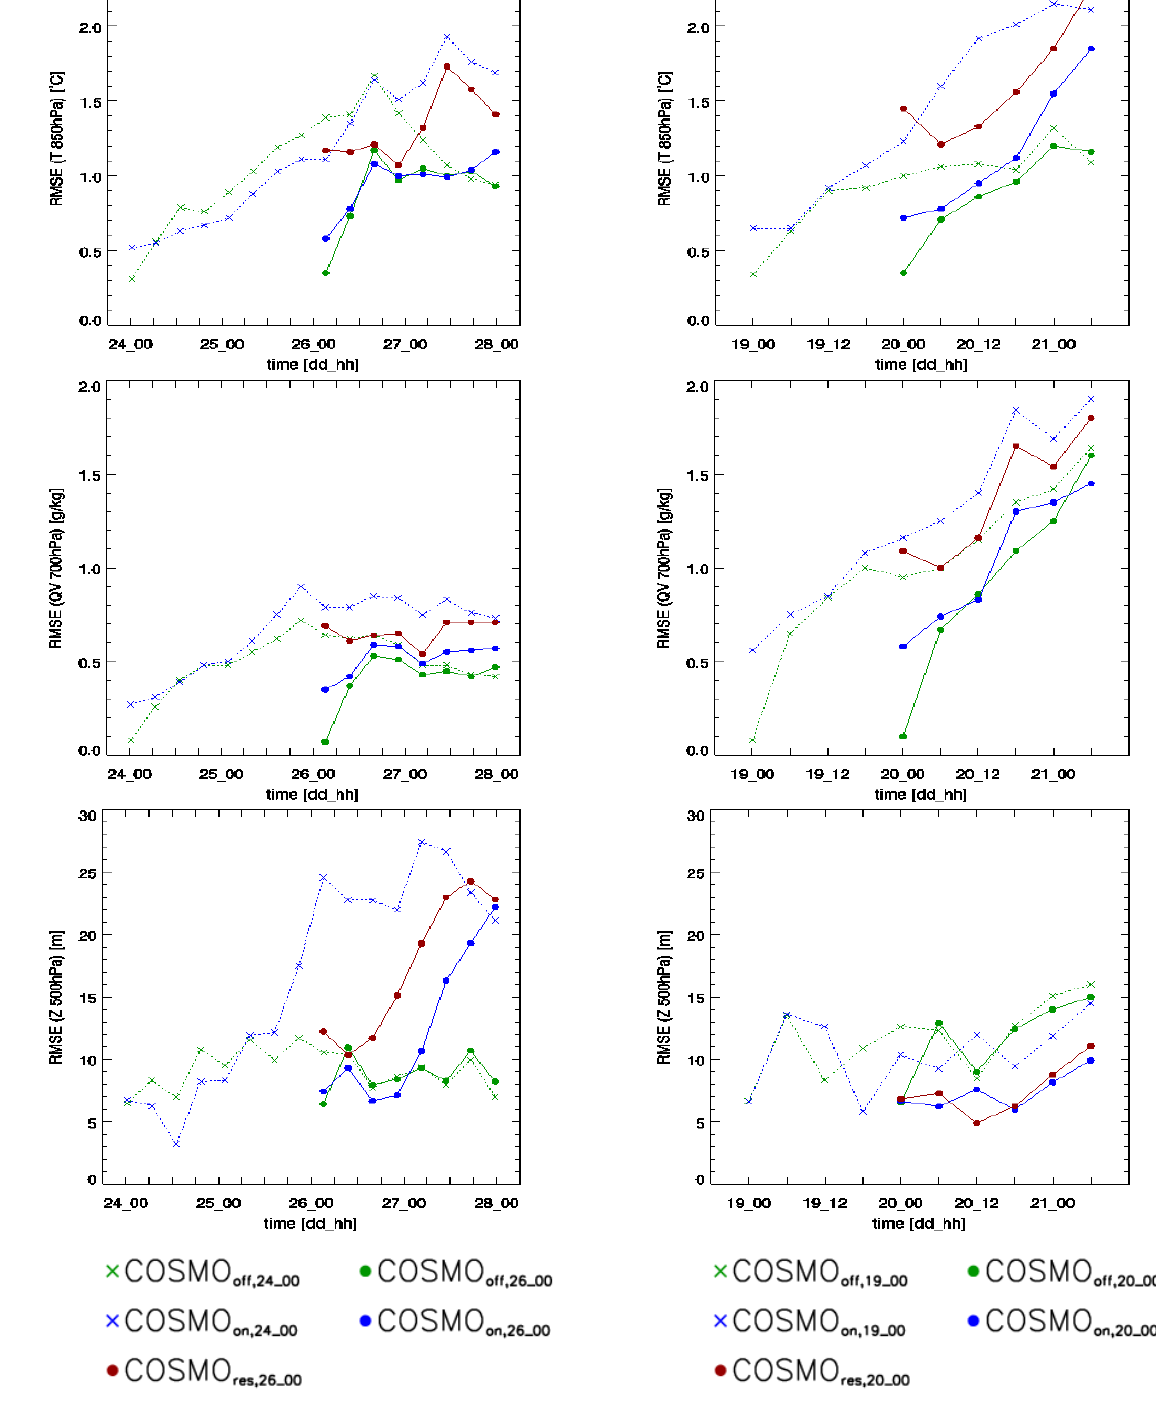
Fig. 14. Time series of the RMSE for two case studies: cold-frontal passage in March 2010 (left, Sect. 5.1) and convective front in July 2007 (right, Sect. 5.2). Top panels show RMSE of temperature at 850 hPa (in ◦ C), middle panels RMSE of specific humidity at 700 hPa (in g kg − 1 ) and bottom panels RMSE of geopotential height at 500 hPa (in m).